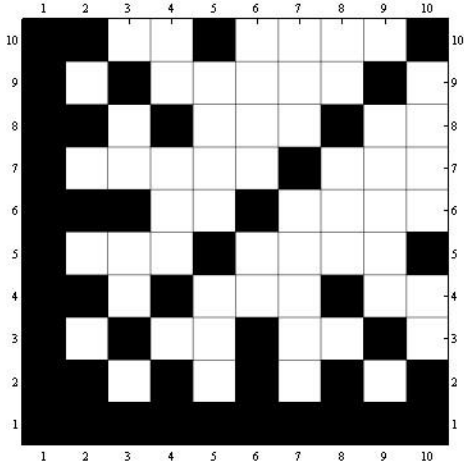
Figure 1. The Mod[x,y] gives the remainder on division of x by y, the indicator matrix for the first eleven natural numbers is taking into account Equation (3).